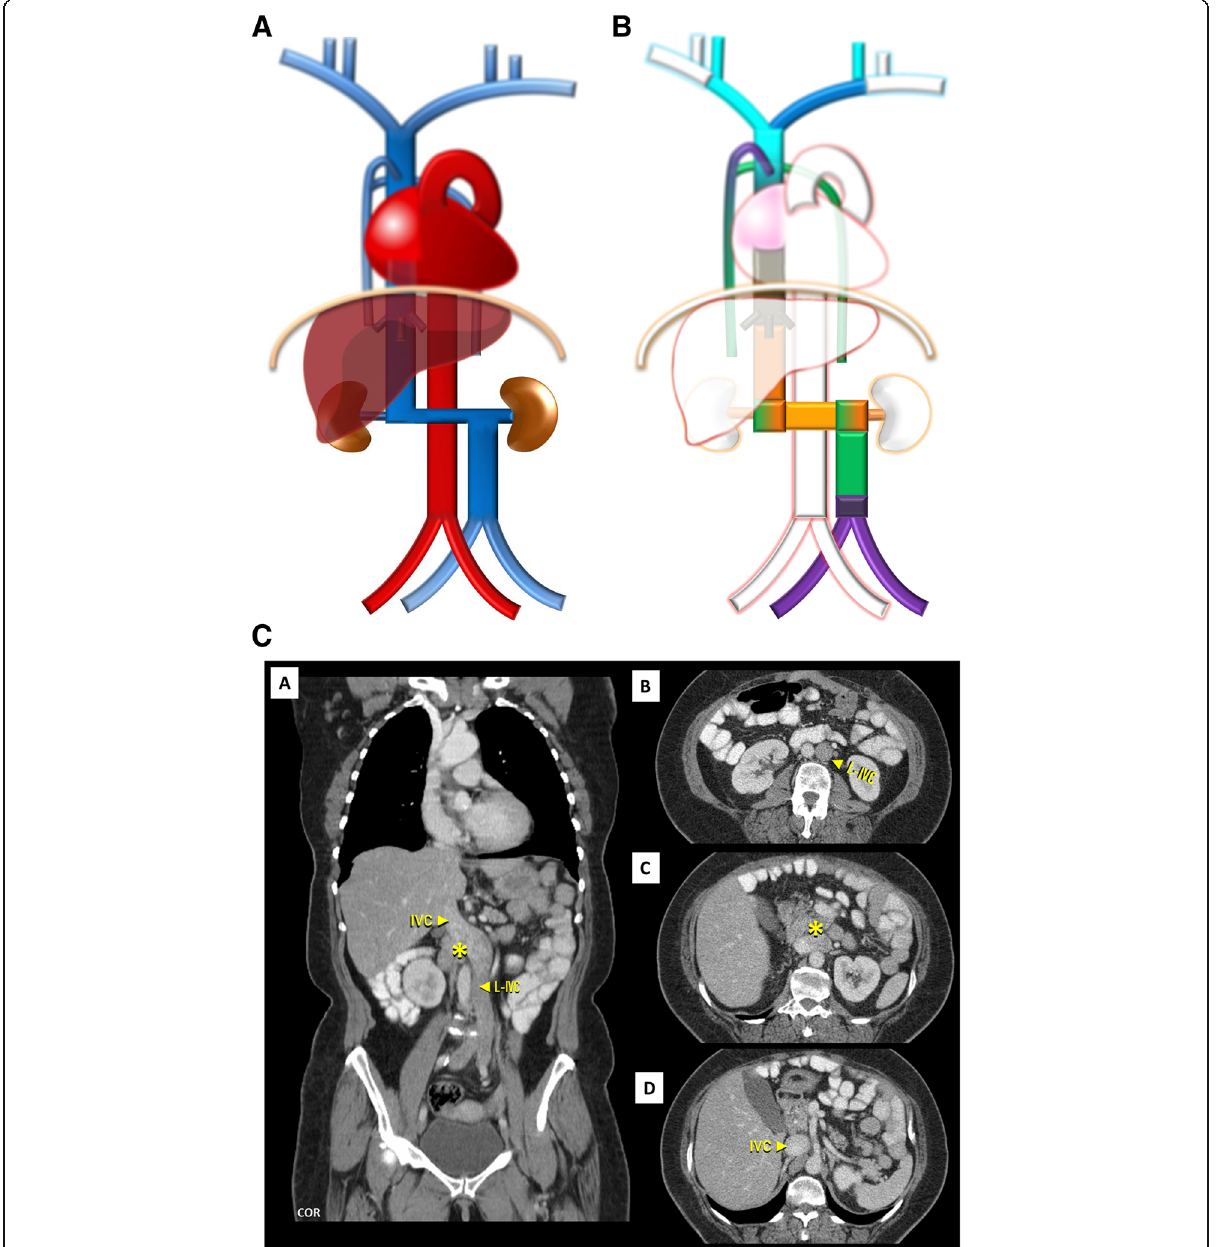
Fig. 7 a Left-sided IVC schematic. Being different from duplication as the infrarenal segment of the right IVC is absent .The left IVC joins the left renal vein, which in normal fashion crosses ventrally the aorta to join the right renal vein from which results a normal suprarenal segment of the IVC. b Left-sided IVC embryology schematic. Left-sided IVC resulting from the regression of the right supra cardinal vein, in addition to the persistence of the left supra cardinal vein. c Left-sided IVC imaging. Contrast-enhanced CT showing a left-sided IVC (L-IVC), which characteristically joins the left renal vein, who in a normal fashion crosses ventrally to join the right renal vein (asterisk) and form a normal suprarenal segment of the